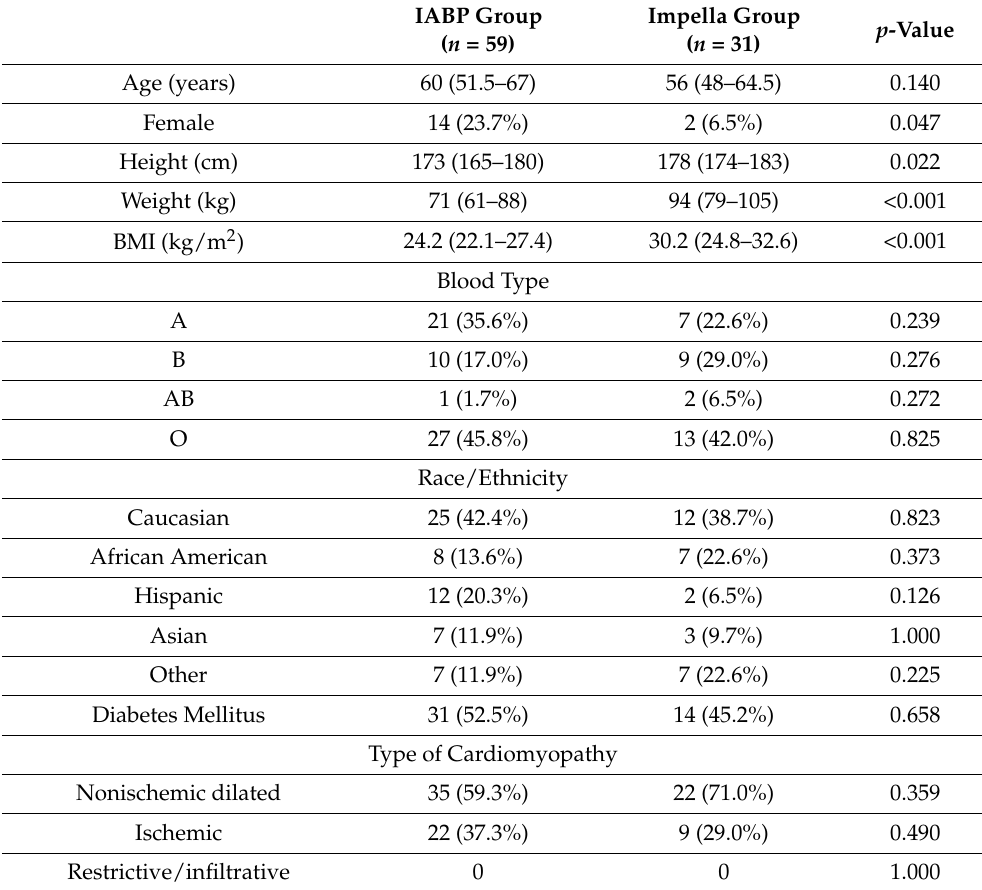
Table 1. Clinical